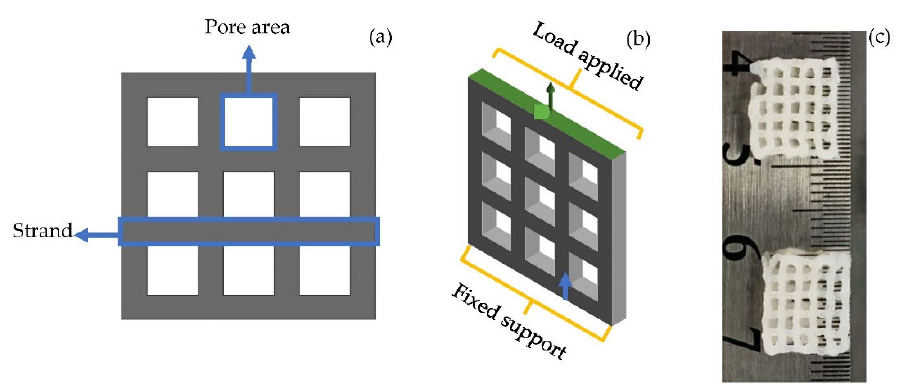
Table 3. Characterisation of the scaffold.